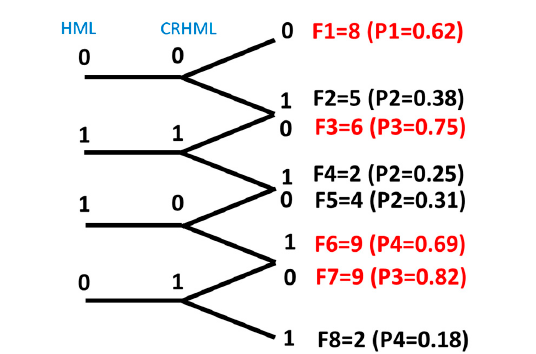
Figure A13. Use HML and CRMHL to forecast the direction of CRMHL.